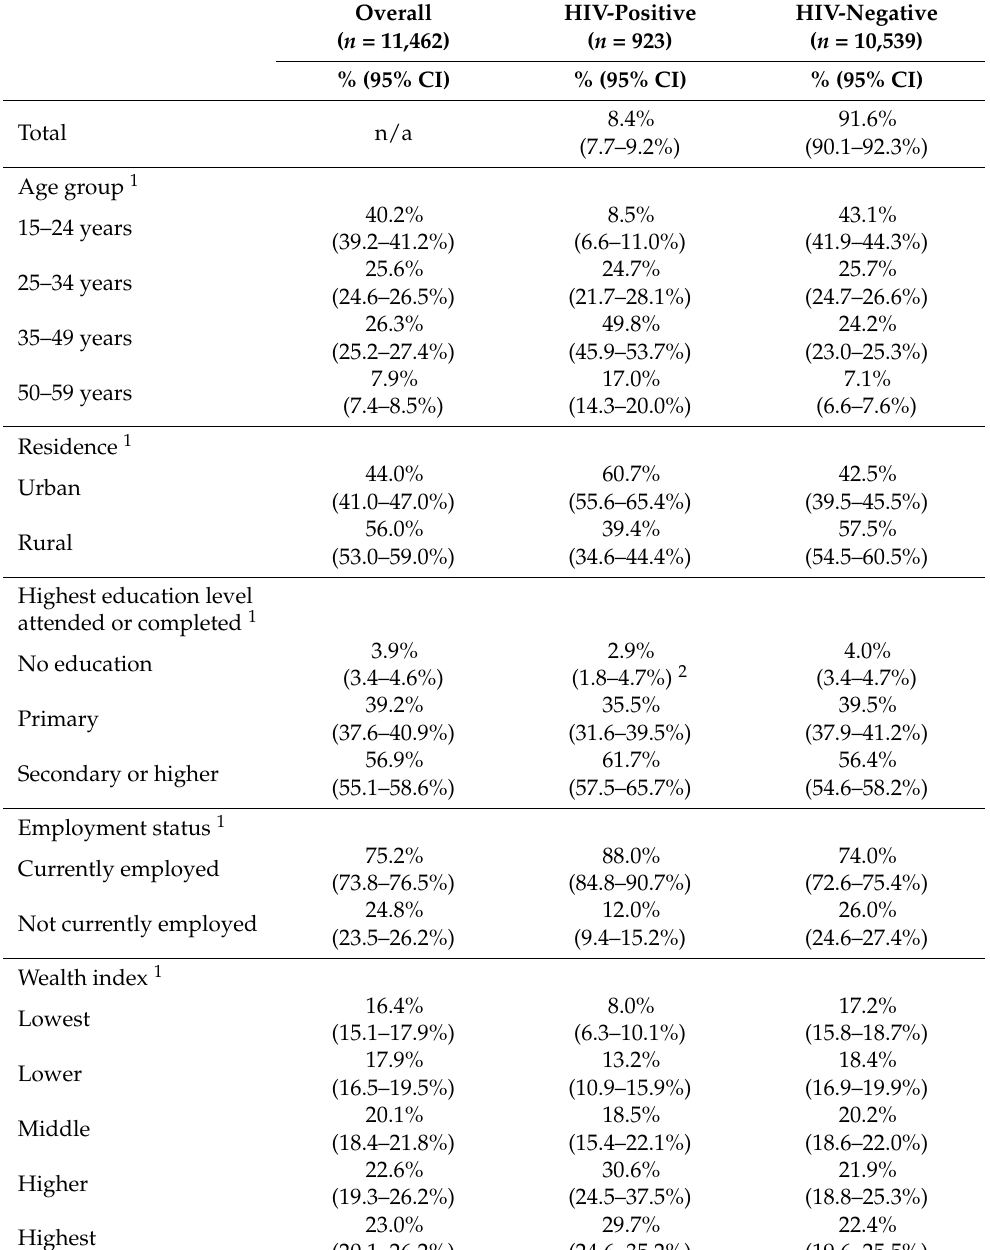
Table 2. Distribution of selected sociodemographic and other characteristics, and tobacco use, among men aged 15–59 who were HIV-positive and HIV-negative—2018 DHS,